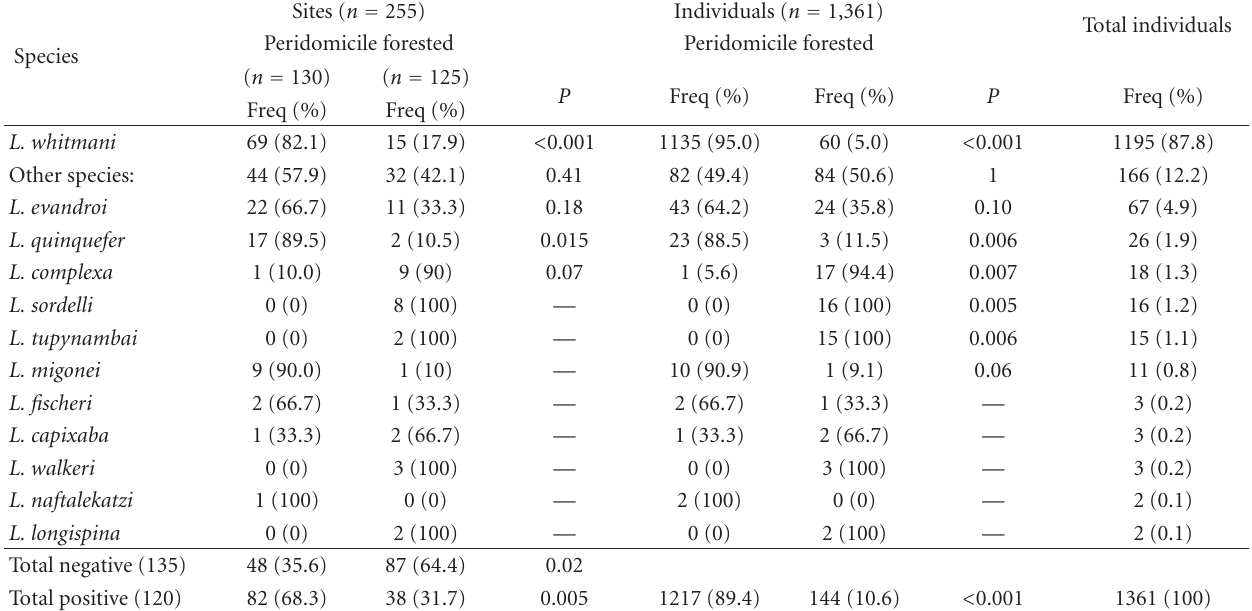
Total individuals